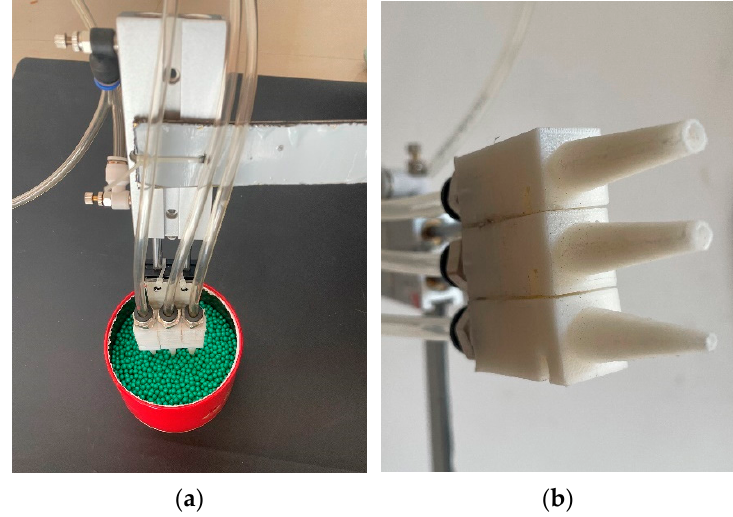
Figure 21. Test nozzle experiment. ( a ) Seed suction test stand. ( b ) Seed suction port of each diameter.